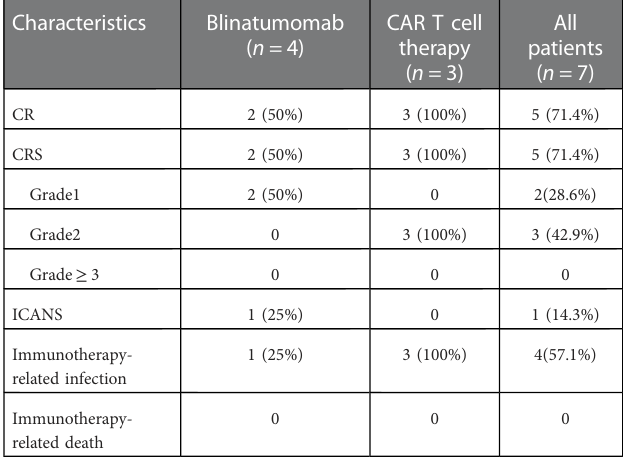
TABLE 3 Response and toxicity of immunotherapy. Characteristics